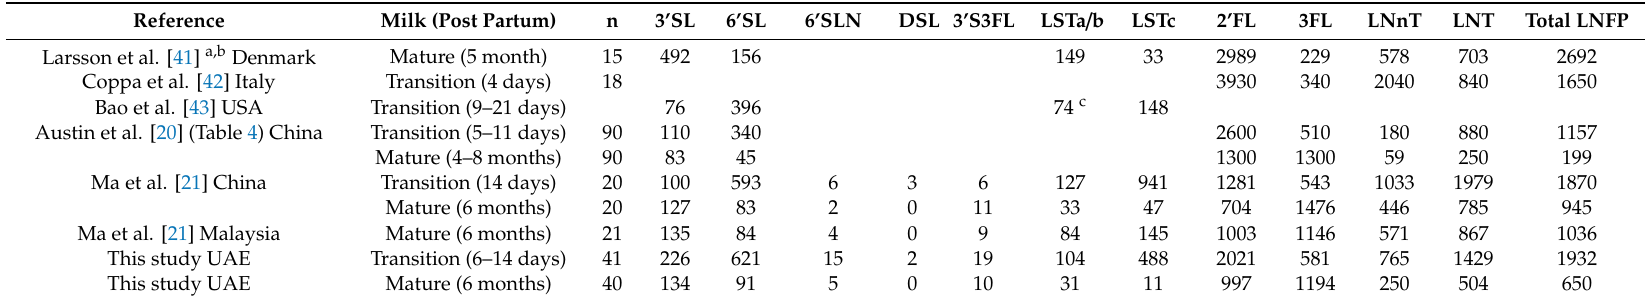
a secretors only. b calculated from nmol / mL data. c LSTb